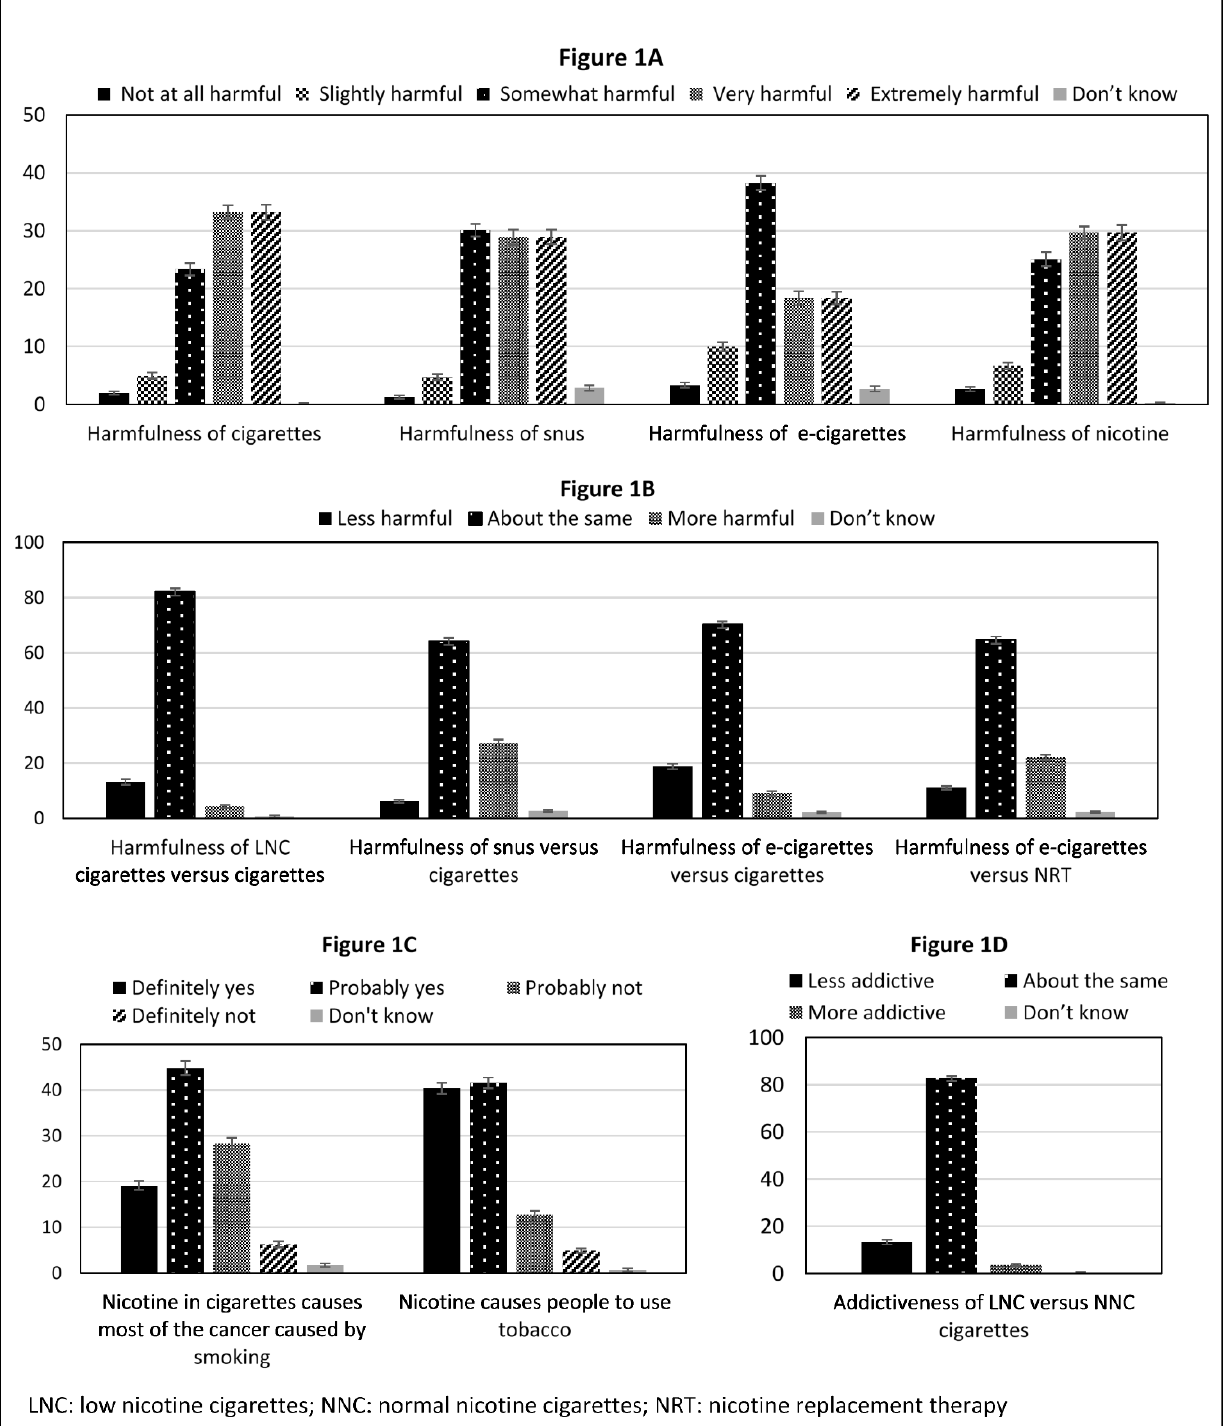
Figure 1. Proportions and 95% confidence intervals for response categories. Persons who currently smoke daily or some days ( n = 8430). ( A ) displays the perceived harm of products; ( B ) displays the relative risk of products; ( C ) displays health risks of nicotine; ( D ) displays the relative addictiveness of low nicotine cigarettes versus normal nicotine cigarettes. Distributions of perceptions among respondents who smoke daily (i.e., removing re- spondents who smoked some days, n = 1785) are shown in Supplementary Figure S1A–D and Supplementary Table S1. Results were similar to those when including respondents